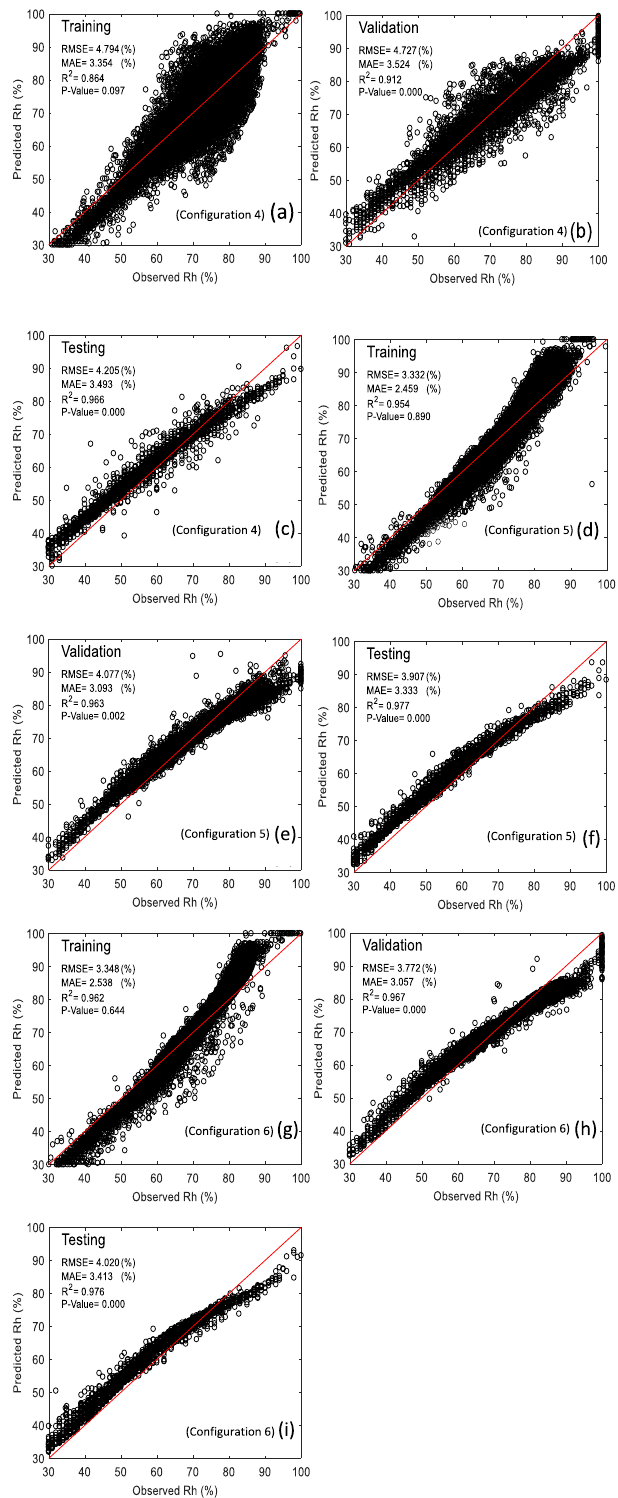
Fig. 10 Scatter plot of training, testing, validation steps, and all data for scenario